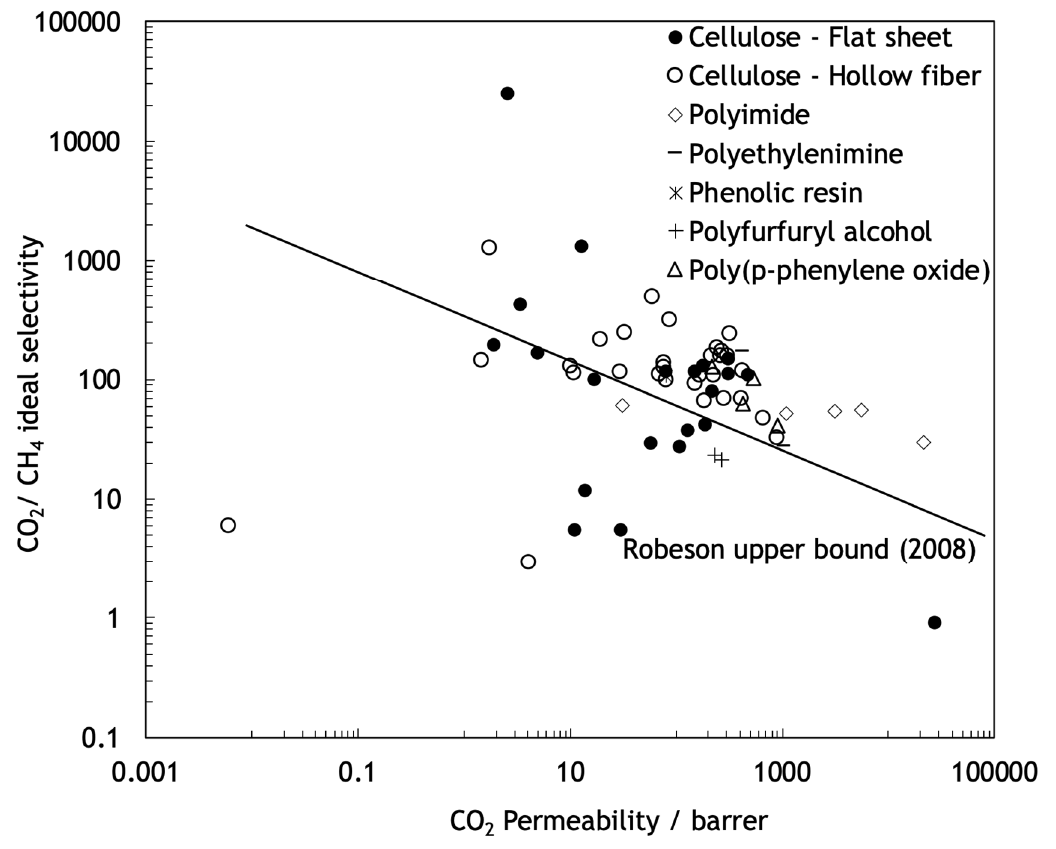
Figure 12. Separation performance of CMSM with different polymeric precursors for CO 2 /CH 4 Separation performance of CMSM with di ff erent polymeric precursors for separation. CO 2 / CH 4